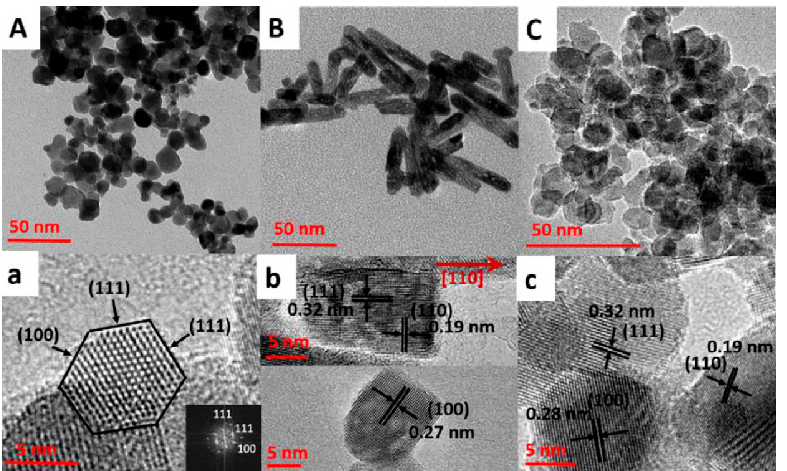
Figure 3. TEM ( top ) and HRTEM ( bottom ) images of Ce x Zr 1 − x O 2 prepared using hydrothermal synthesis: ( A , a ) polyhedral, ( B , b ) rod-shaped and ( C , c ) plates [46]. Reprinted from Yang, Z.; Hu, W.; Zhang, N.; Li, Y.; Liao, Y. Facile synthesis of ceria–zirconia solid solutions with cubic–tetragonal interfaces and their enhanced catalytic performance in diesel soot oxidation. J. Catal. 2019 , 377 , 98–109, with permission from Elsevier.